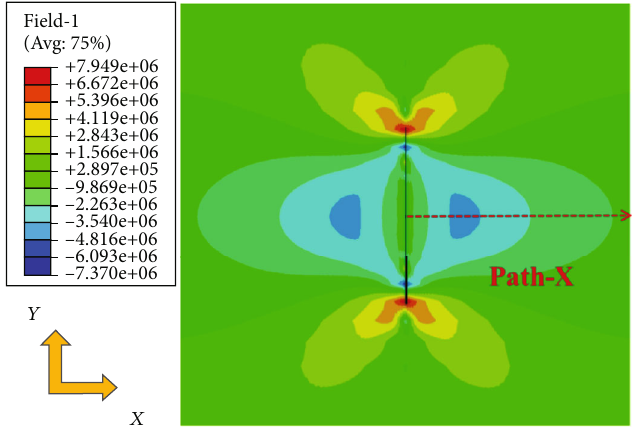
Figure 5: Variation results of in situ stress di ff erence after